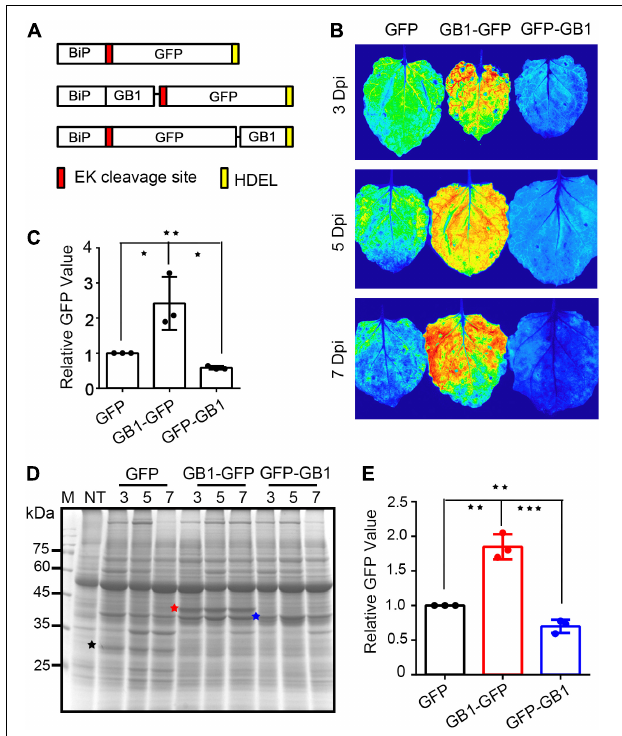
FIGURE 2 | C-terminal fusion of GB1 does not enhance the expression level of GFP in the ER of Nicotiana benthamiana . (A) Schematic representation of constructs. BiP-EK-GFP-HDEL (top), BiP-GB1-EK-GFP-HDEL (middle), and BiP-EK-GFP-GB1-HDEL (bottom). (B) Images of GFP fluorescence. The indicated constructs were expressed in leaf tissues of N . benthamiana via agroinfiltration, and images were taken at 3, 5, and 7 DPI. GFP (top), GB1-GFP (middle), and GFP-GB1 (bottom). (C) Quantification of GFP fluorescent signals. Signal intensity was quantified using three DPI samples. Three independent experiments were carried out. (D) GFP level by CBB staining. Total protein extracts from leaves harvested at 3, 5, and 7 DPI were separated by SDS-PAGE and stained with CBB. GFP band intensity was quantified from the CBB-stained gel after SDS-PAGE. (E) Quantification of GFP levels. The GFP bands in Figure (D) were quantified and represented as relative values.Results for panels (C,E) are the mean ± SD ( n = 3). Asterisks indicate a significant difference (Student’s t-test; one, two, and three asterisks indicate P < 0.05, 0.001 < P < 0.05, and P < 0.001,